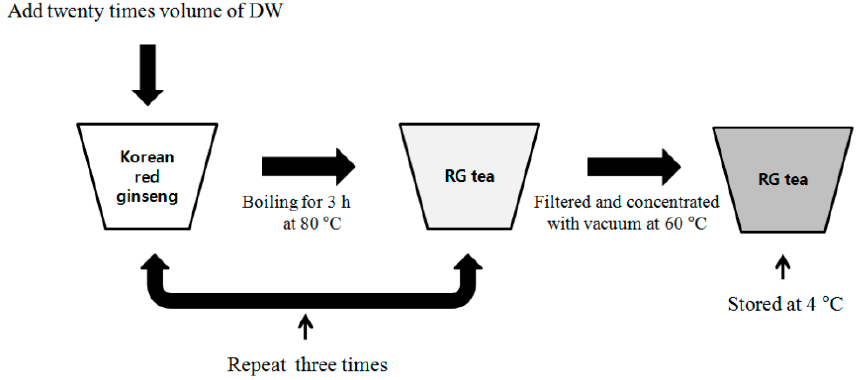
Figure 1. Red ginseng extracts (RG) preparation process.